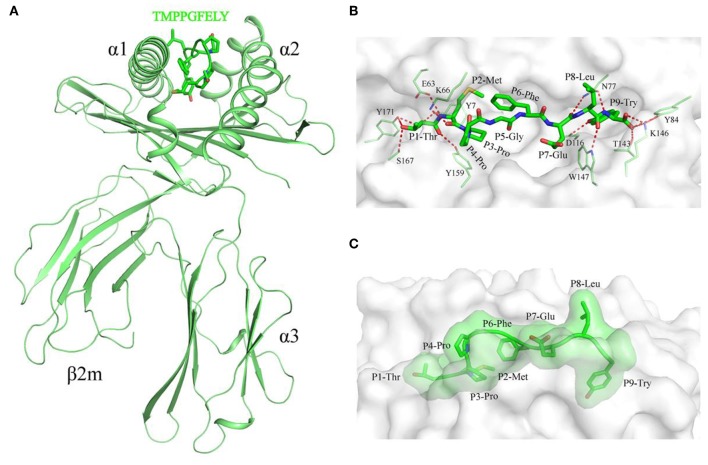
Structural overview and NSP9-TMP9 peptide presentation in pSLA-1*1502. (A) Overall structure of SLA-1*1502 in complex with the NSP9-TMP9 peptide. The non-apeptide is shown in stick representation between the α1 domain and α2 domain of pSLA-1*1502. (B) Interactions between the NSP9-TMP9 peptide and residues in the PBG. The hydrogen bonds are represented as red dashes. (C) Surface model of NSP9-TMP9. Most regions of P4-Pro and P8-Leu are located outside the PBG.